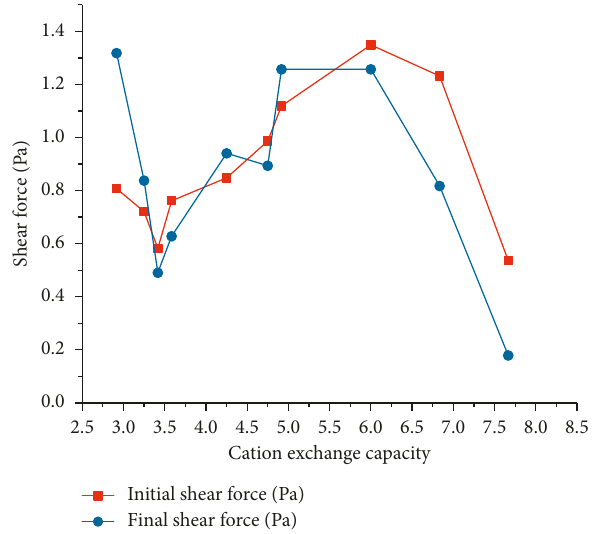
Figure 10: Curve of static shear force of slurry